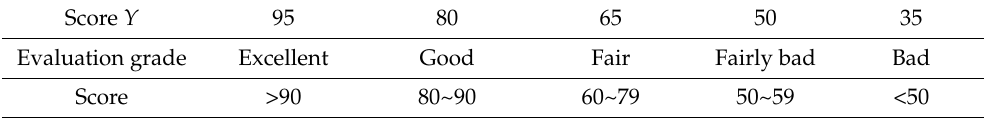
Table 4. Performance scoring table of the water-cooling system of the turbocharger bearing